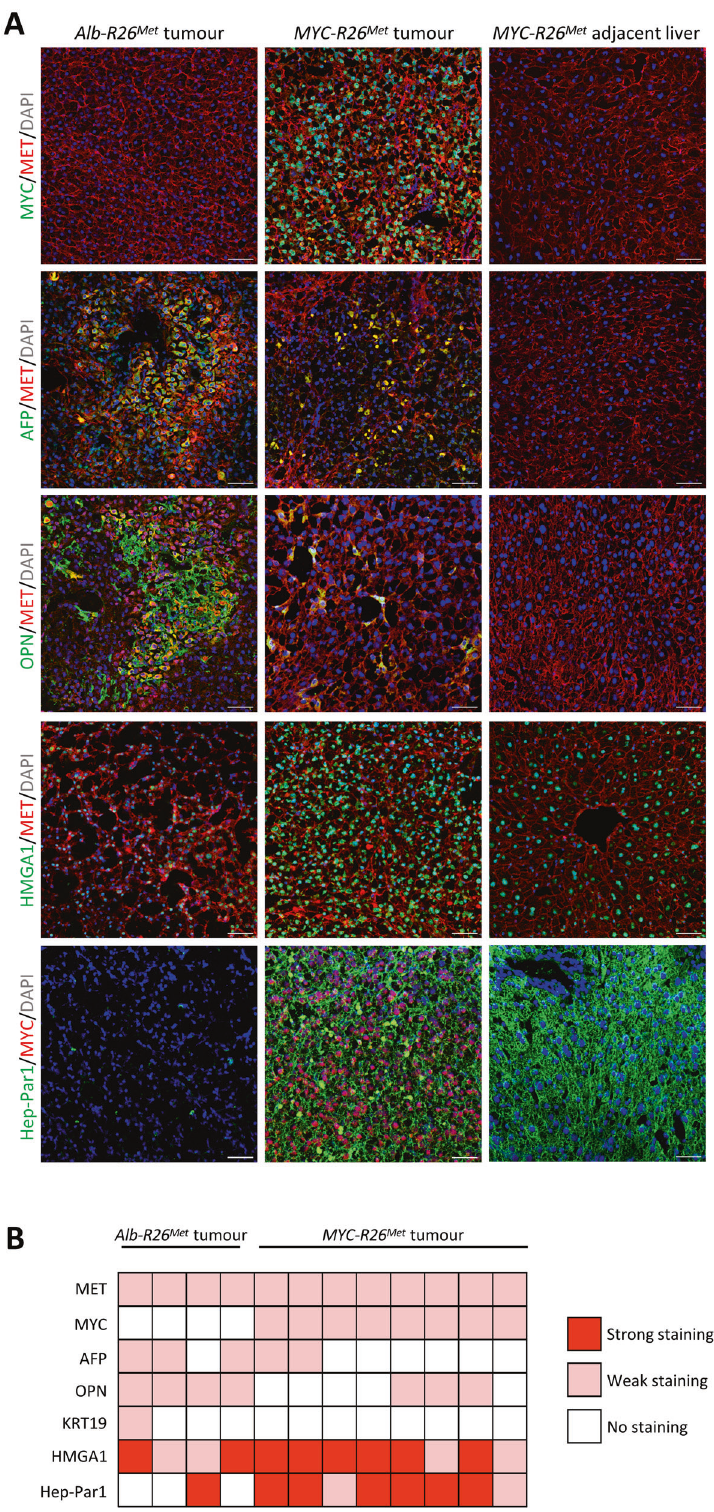
Fig. 4 Molecular characteristics of Myc-R26 Met and Alb-R26 Met tumours. A Representative images of immuno fl uorescence staining of Myc- R26 Met and Alb-R26 Met tumour sections (and Myc-R26 Met adjacent livers as controls), documenting the expression of MET, MYC, AFP, OPN, and EPCAM (scale bar: 50 µm). Nuclear staining in DAPI (blue). B Heatmap reporting the intensity of staining of immuno fl uorescence images for proteins reported on the left. Each square represents a distinct tumour sample.